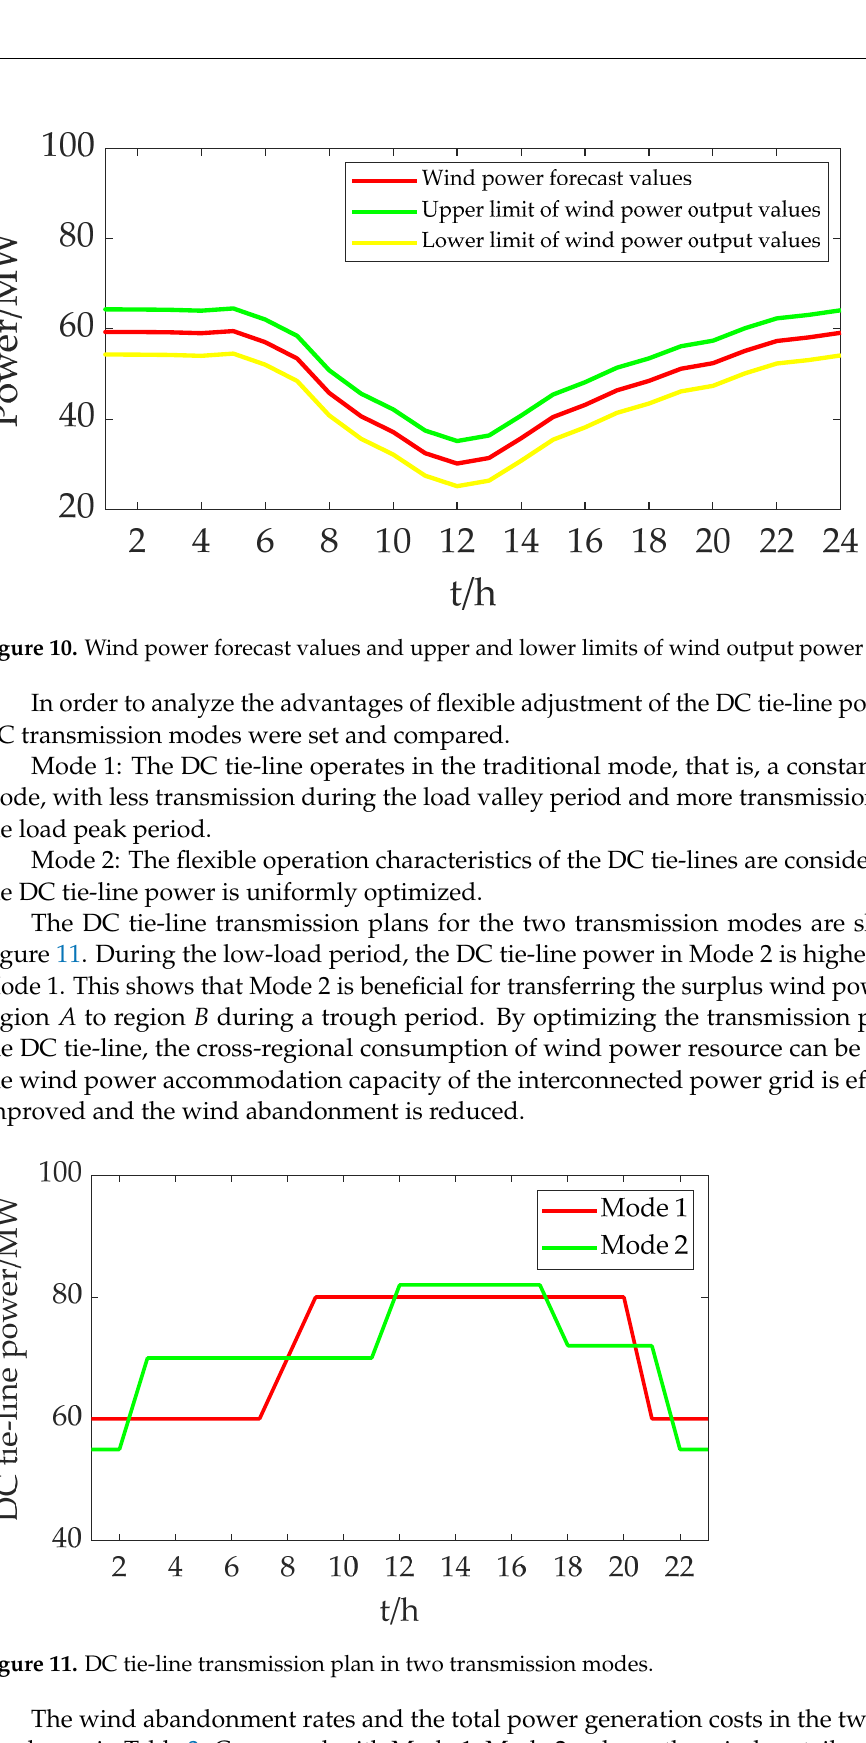
Figure 9. Load output power forecast values.